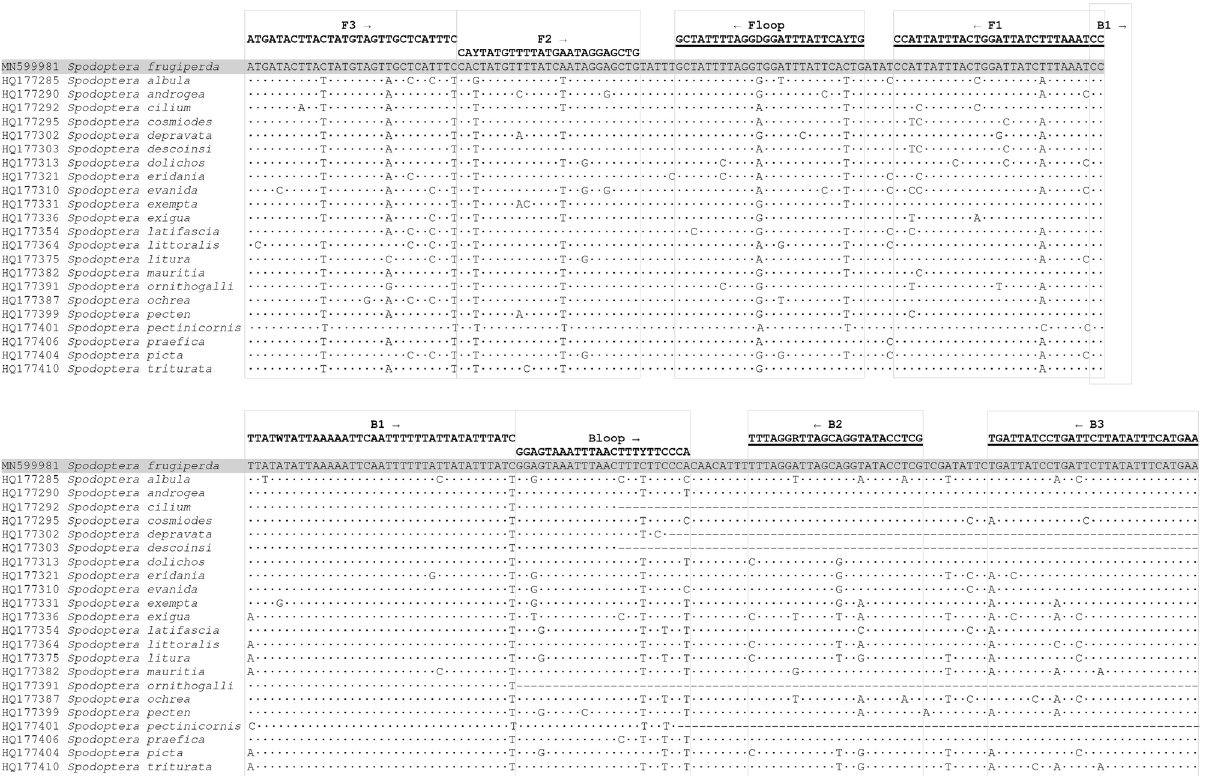
Figure 2. Mitochondrial COI DNA sequence (3 ′ region) alignment showing FAW LAMP primers. Sequence of FAW (grey shading, from Kim et al . 37 ) and other closely related Spodoptera species 20,55 obtained from GenBank. Reverse primers are underlined; FIP (5 ′ -3 ′ ) is made by combining F1 (reverse compliment) and F2; BIP (5 ′ -3 ′ ) is made by combining B1 and B2 (reverse compliment).